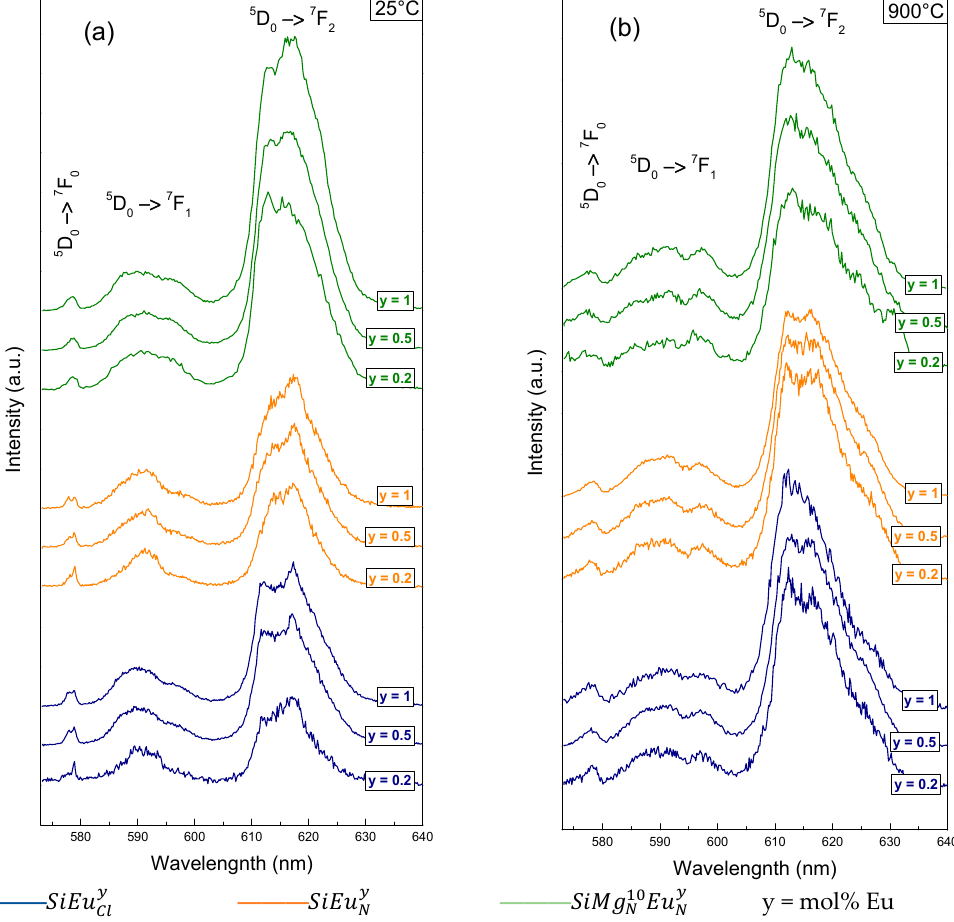
Figure 4. Room temperature emission spectra of the different samples ( a ) before and ( b ) after the thermal treatment at 900 °C (Intensities are normalized to the maximum of the 5 D 0 → 7 F 1 emission band).